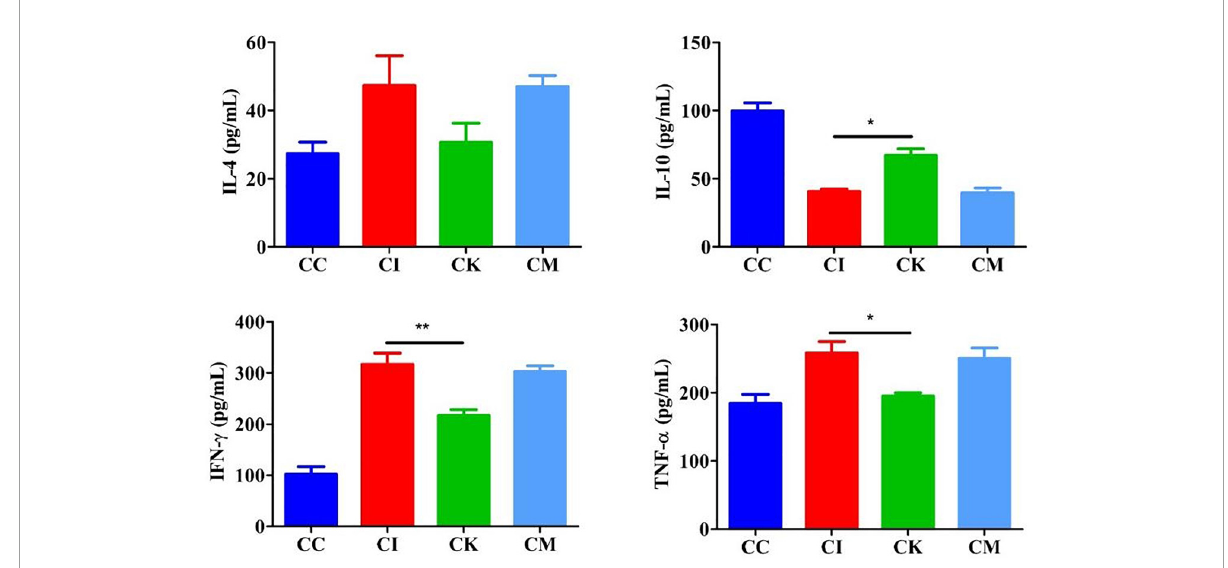
FIGURE5 Serum levels of IL-4, IL-10, IFN- γ , and TNF- α in mice with chronic T. gondii infection at 14 dpi. CC: no T. gondii + PBS; CI: 3 T. gondii cysts + PBS; CK: 3 T. gondii cysts + koumiss; CM: 3 T. gondii cysts + mare’s milk. All data are expressed as mean ± SD. * P < 0.05; ** P < 0.01.